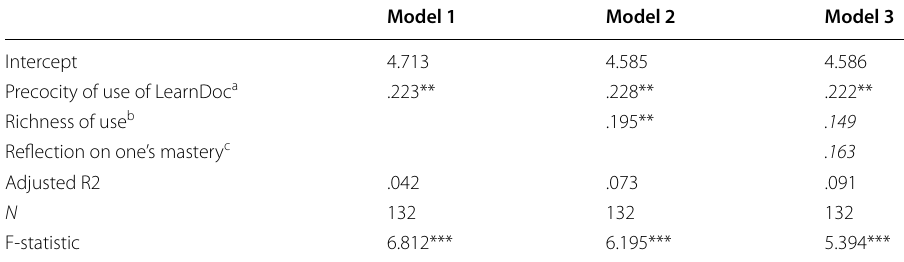
Table 5 Contributions to the learners’ overall grades at the final exams by various groups of variables extracted from LearnDoc